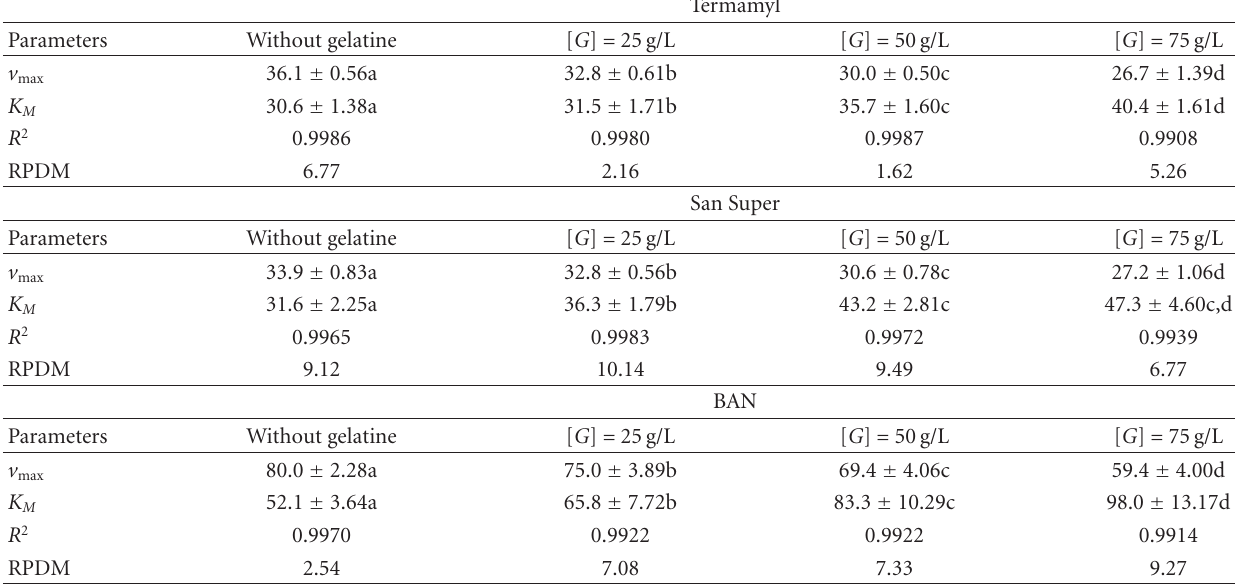
Table 4: Statistically significant ( P < 0 . 05) values (means ± standard errors) of the parameters in the Michaelis-Menten model (1) for the enzymatic reactions of the three amylolytic enzymes in starches mixed with di ff erent initial gelatine [ G ] concentrations (0, 25, 50, and 75g/L). The mean values within rows followed by the same letter are not significantly di ff erent ( P < 0 . 05) from each